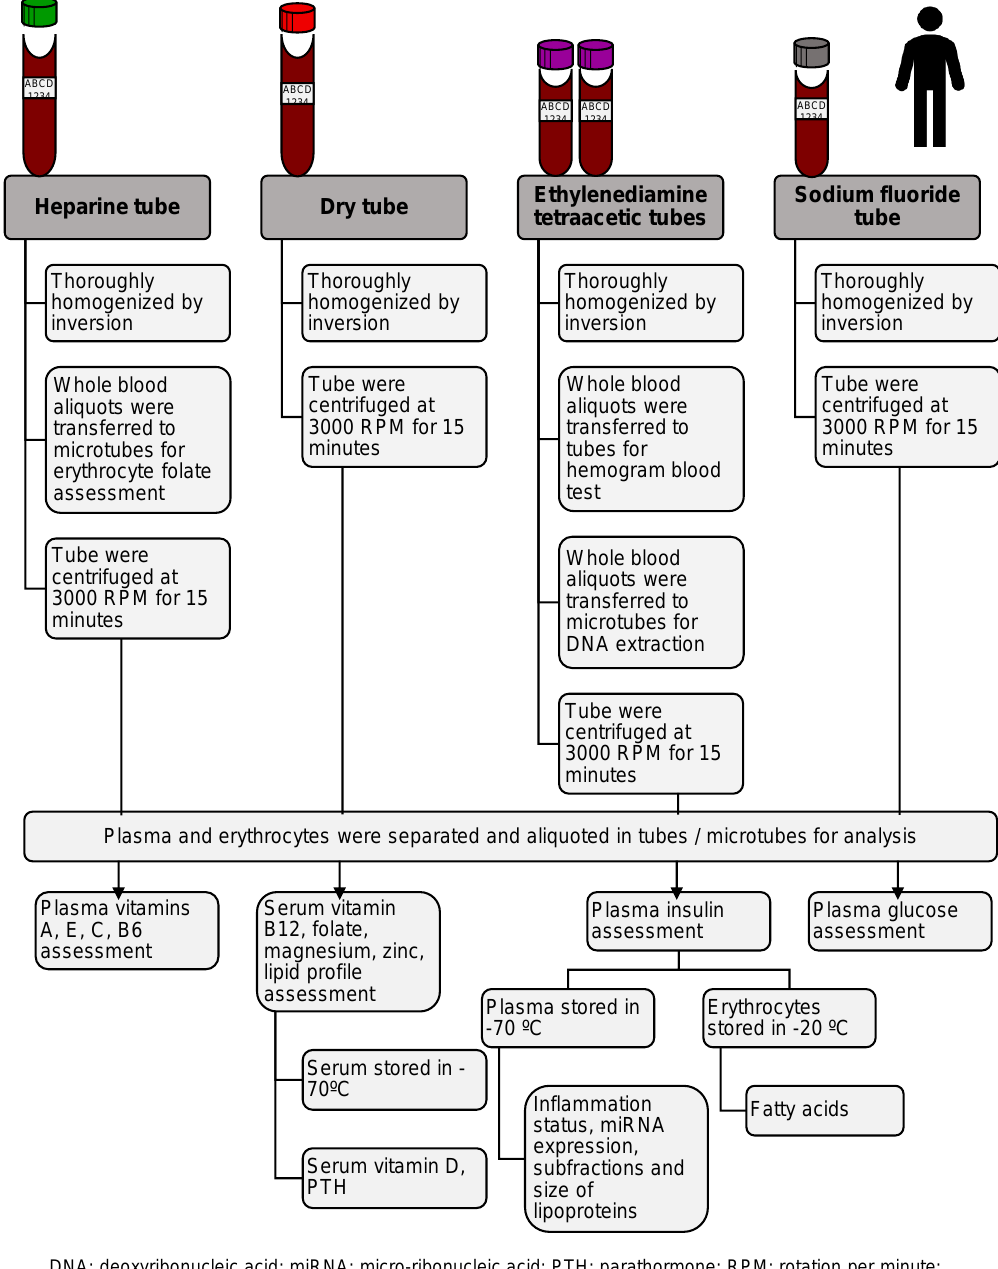
Figure 3. Laboratory procedures used for blood sample assessment: 2015 ISA-Nutrition. S ã o Paulo,